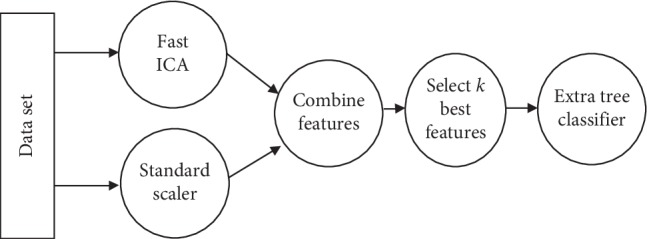
Example of pipeline.